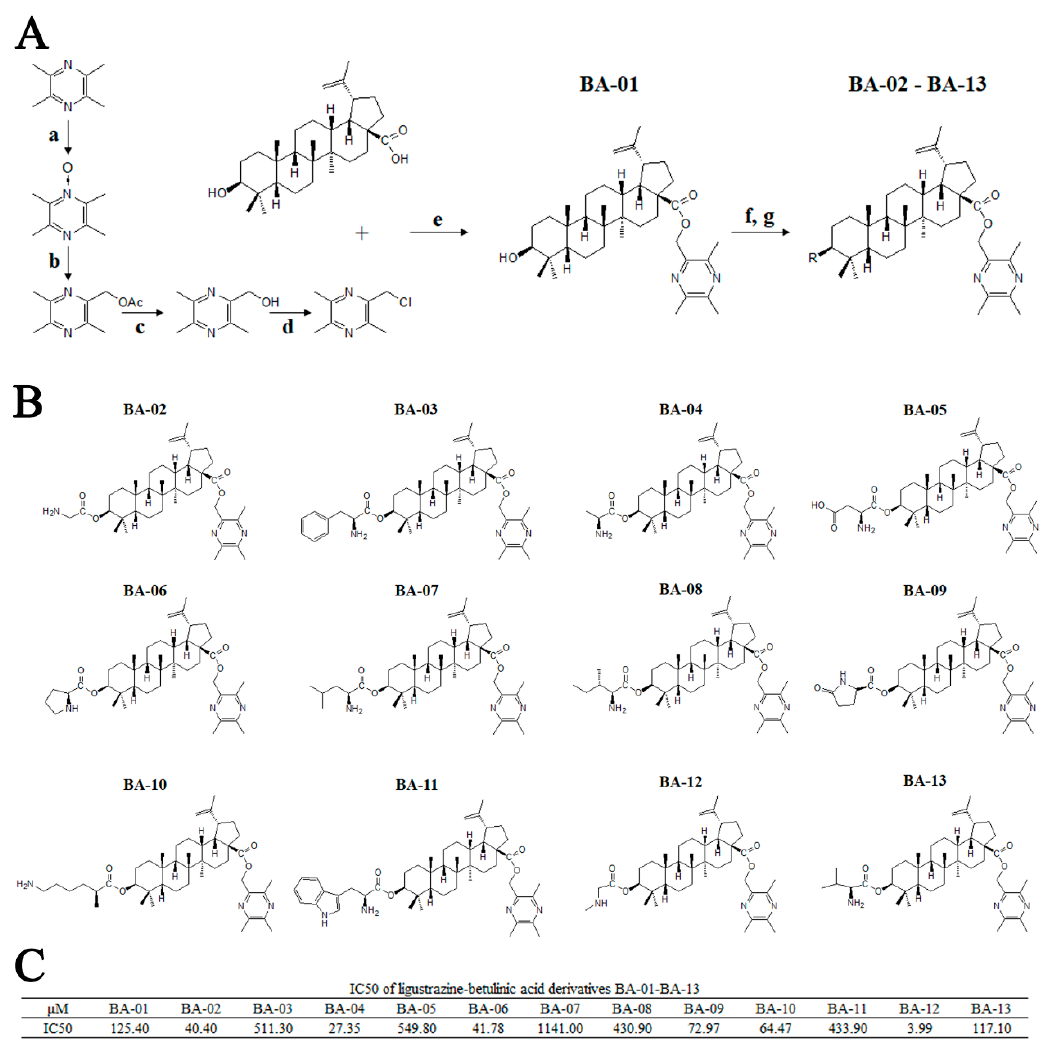
Figure 2. Synthesis, chemical information, and antitumor activities of ligustrazine–betulinic acid derivatives (BA-01–BA-13) on human bladder carcinoma (T24) cells. ( A ) Synthesis of ligustrazine–betulinic acid derivatives (BA-01–BA-13). Conditions and reagents: (a) acetic acid and 30% H 2 O 2 , reflux at 90 °C for 6 h; (b) acetic anhydride, reflux at 105 °C for 2 h; (c) methanol (MeOH):tetrahydrofuran (THF):H 2 O ¼ 1:3:1 with NaOH for 1 h; (d) tosyl chloride (TsCl), THF, 4-dimethylaminopyridine (DMAP), trimethylamine (TEA) for 12 h; (e) dry K 2 CO 3 , dry N , N -dimethylformamide (DMF) at 25 °C for 12 h; (f) N -benzyloxycarbonyl ( N -Cbz) or N -butyloxy carbonyl ( N -Boc) amino acids, DMAP, 1-ethyl-3-(3-dimethylaminopropyl)carbodiimide hydrochloride (EDCI), dichloromethane (DCM) at 25 °C for 12 h; (g) Pd/C (10%), MeOH at 25°C for 12 h, or trifluoroacetic acid (TFA) in dry DCM at 0 °C for 2 h. ( B ) Structures of ligustrazine–betulinic acid derivatives (BA-01–BA-13). ( C ) Half maximal inhibitory concentration (IC 50 ) values of ligustrazine–betulinic acid derivatives (BA-01–BA-13) on T24 cells, evaluated using 3-(4,5-dimethylthiazol-2-yl)-2,5-diphenyltetrazolium bromide (MTT) assays.